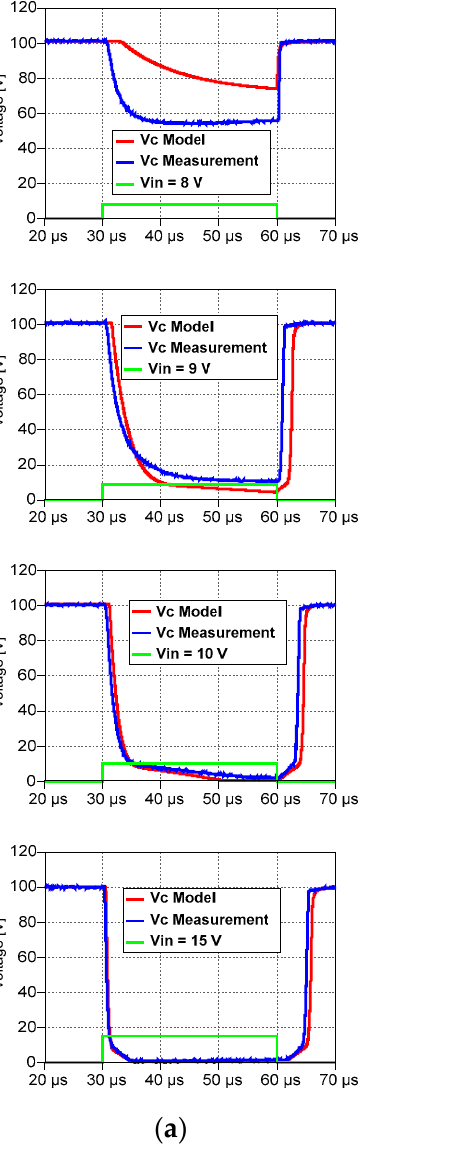
Figure 8. Comparison of collector voltage between basic and improved models. ( a ) First model (Figure 2); ( b ) Improved model (Figure 5).